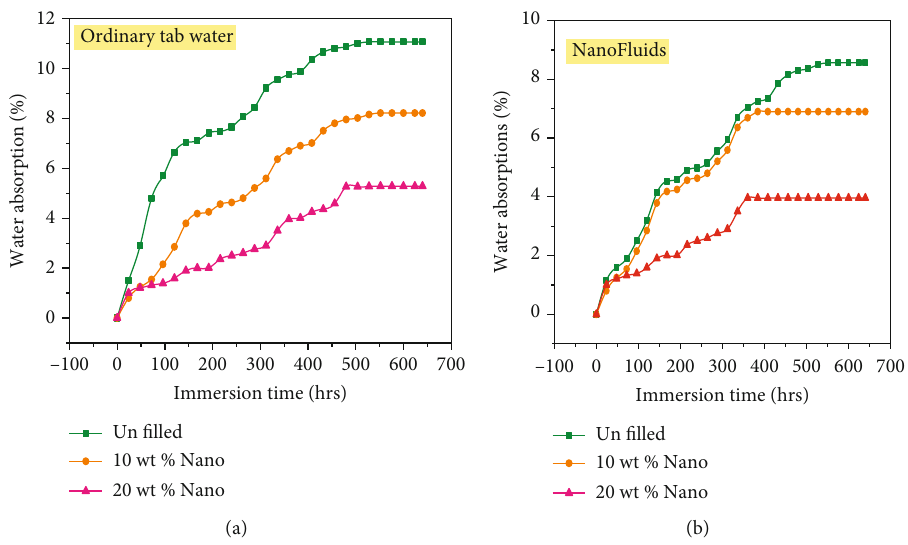
Figure 7: Hygroscopic behaviour of nanocomposites: (a) ordinary tab water; (b) nano fl